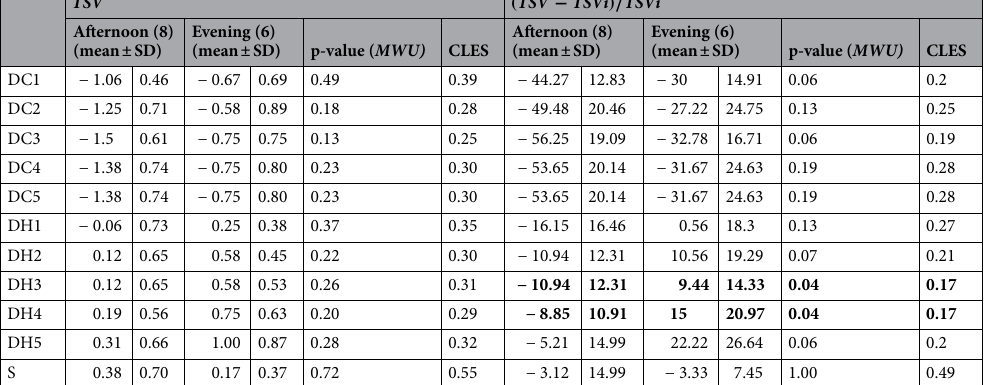
Table 5. Time-of-day differences in thermal sensation vote and its relative change over the course of the last two partial-body cooling and warming transients. Significant values are in bold.